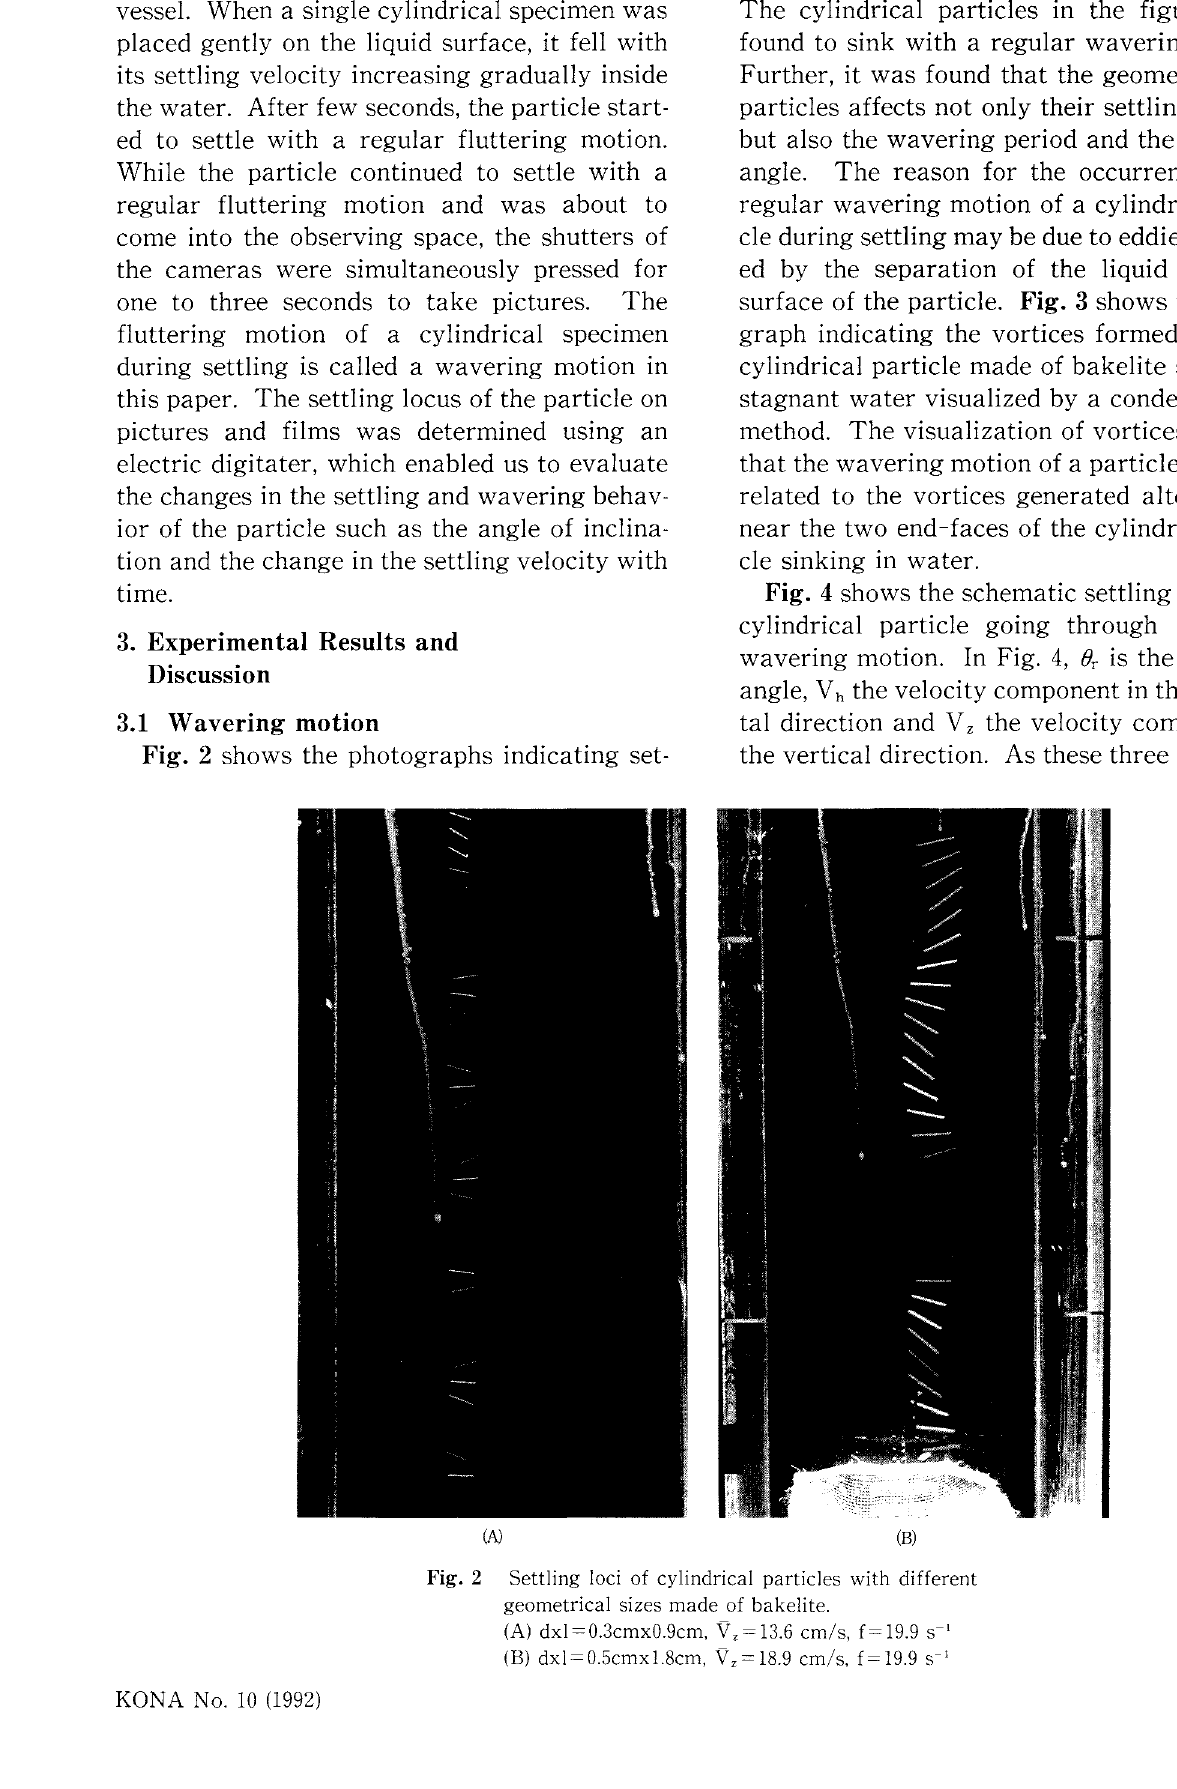
Fig. 2 Settling loci of cylindrical particles with different geometrical sizes made of